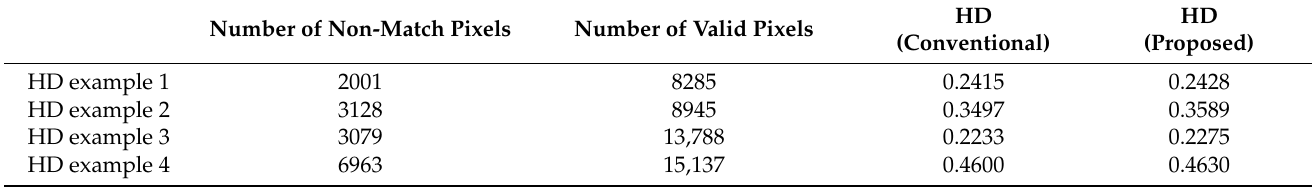
Table 2. Comparison of the conventional method and the proposed method for Hamming Distance calculation. Number of Non-Match Pixels